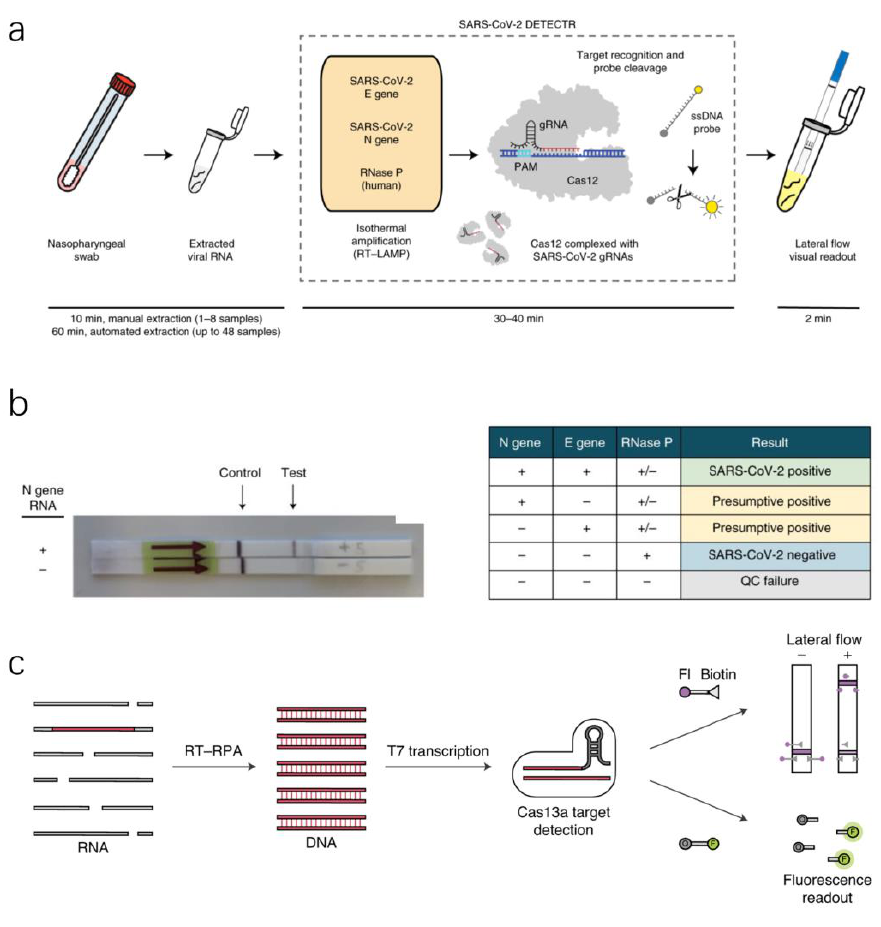
Figure 5. A CRISPR–Cas-based assay for detection of SARS-CoV-2. ( a ) Conventional RNA extraction can be used as an input to DETECTR, which is visualized by a fluorescent reader or lateral flow strip [52]. ( b ) Lateral flow strip assay readout. A positive result requires the detection of at least one of the two SARS-CoV-2 viral gene targets. QC, quality control [52]. ( c ) SHERLOCK detection of SARS-CoV-2 RNA [53]. (Copyright © 2020, The Author(s), under exclusive licence to Springer Nature America, Inc.) (Copyright © 2020, The Author(s), under exclusive licence to Springer Nature Limited). Table 3. The data and applications of off-chip CRISPR – Cas detection technology are summarized. Lower Sample Type Detection